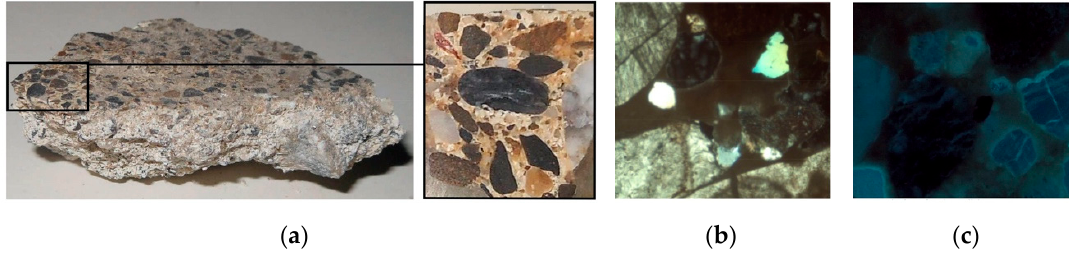
Figure 14. ( a ) Floor sample with detail: ( b ) 40× photomicrograph (thin section, crossed nicols) and ( c ) 40× photomicrograph (thin section, ultraviolet light transmitted).